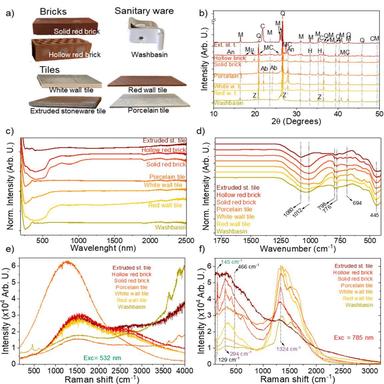
Ceramic group (solid and hollow red bricks, white and red wall tiles, porcelain tile and extruded stoneware tile and washbasin characterization composed by a) photographs, b) X-Ray diffraction patterns, c) UV-SWIR, d) FTIR, e) Raman spectra with 532 nm excitation source and f) Raman spectra with 785 nm excitation source. Legend: XRD: M: mullite, Q: quartz, C: cristobalite, An: anorthite, Mu: muscovite, MC: microcline, H: hematite, Ab: albite and Z: zircon.